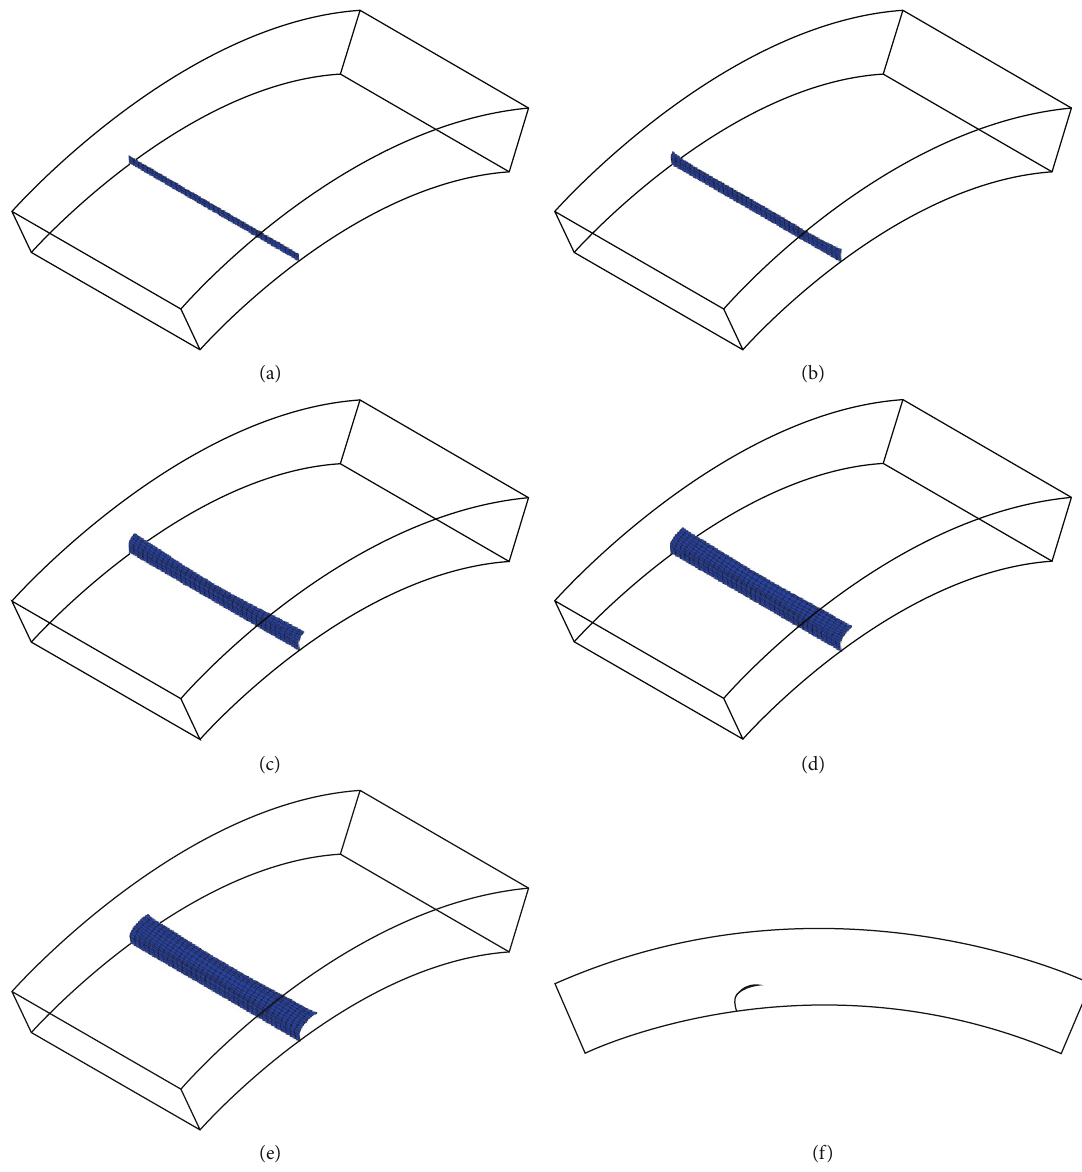
Figure 12: Crack propagation in tunnel lining segment of numerical model Z2: (a – e) 3D view; (f) 2D view (the fi nal crack in the